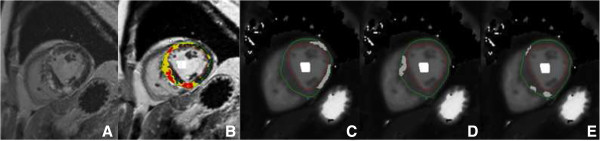
The selection of myocardial regions with different signal intensities in a LGE-positive HCM patient. Image A represents a short axis LGE image of a HCM patient, showing extensive focal fibrosis in the myocardium (white areas). The maximum signal (max SI) was determined by drawing a small ROI in the core of the region with focal fibrosis. Image B, which is the identical CMR image as (A) but with a segmentation overlay, shows non-enhanced myocardium (SI <20% max SI), intermediate enhanced myocardium in yellow (>20 and <50% of max SI) and enhanced myocardium in red (SI >50% of max SI) using the thresholding algorithm. Image C, D, and E show manually drawn ROI’s on corresponding T1 maps for non-enhanced, intermediate enhanced, and enhanced myocardium, respectively. LGE = late gadolinium enhancement. SI = signal intensity. ROI = region of interest.